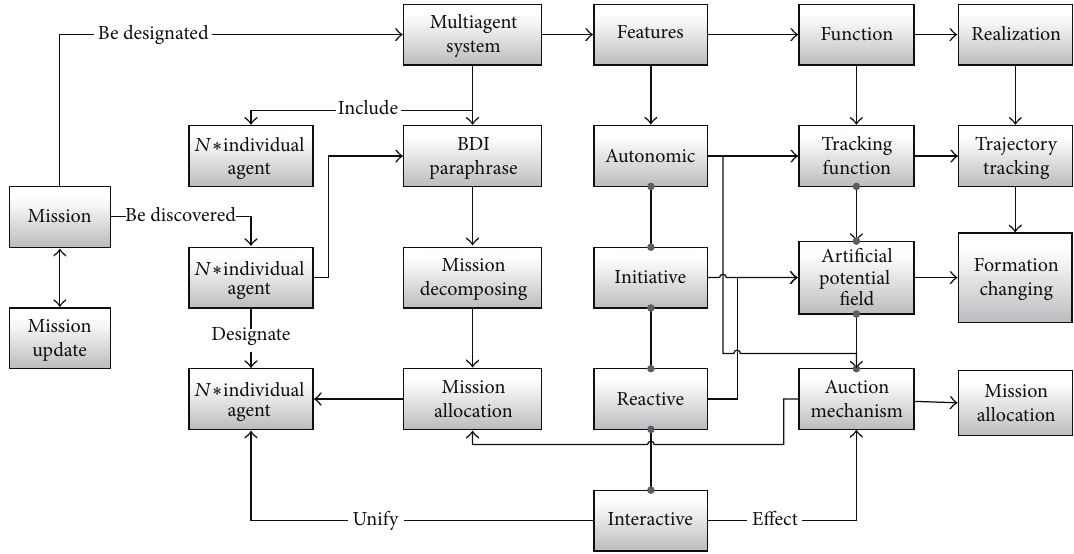
Figure 1: Structure of the cooperative system based on agent.